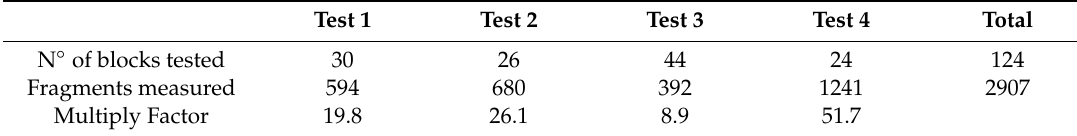
Table 1. Number of initial blocks, fragments measured and multiply factor of each test and in total.